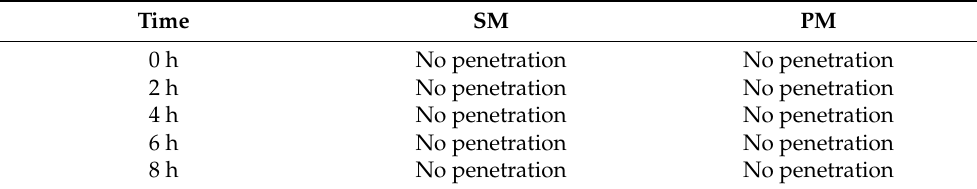
Table 2. Results of synthetic blood penetration resistance after various mask use